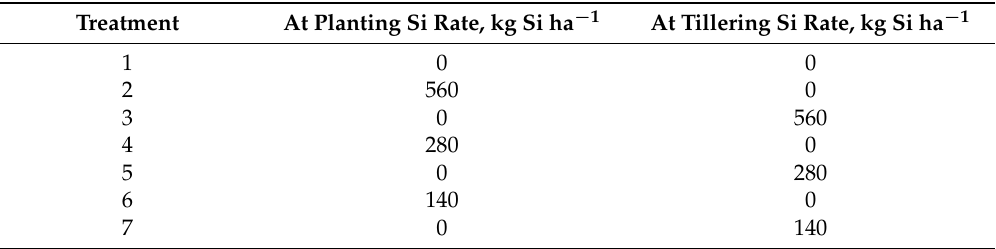
Table 4. Treatment, at planting Si rate, and at tillering Si